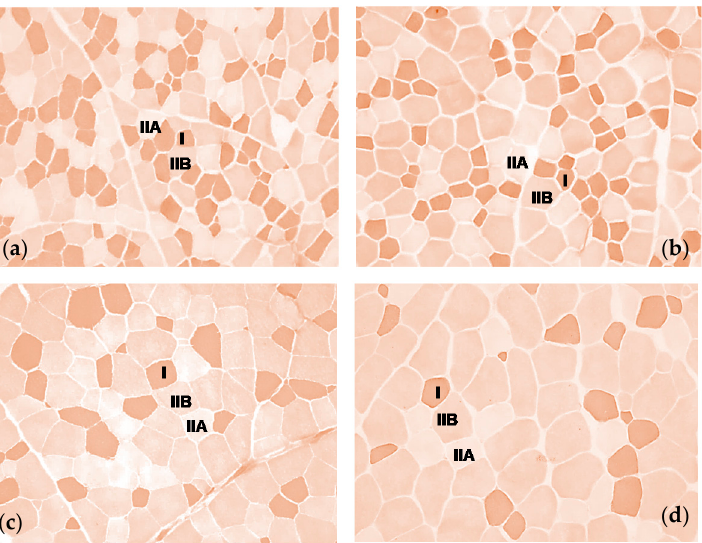
Figure 1. Histochemical m-ATPase staining after acid pre-incubation at pH 4.45–4.47 of: ( a ) Semimembranosus (SM) of Maremmana (MA); ( b ) Triceps brachii (TB) of MA; ( c ) SM of Aubrac (AU); ( d ) TB of AU, using a 10× objective.